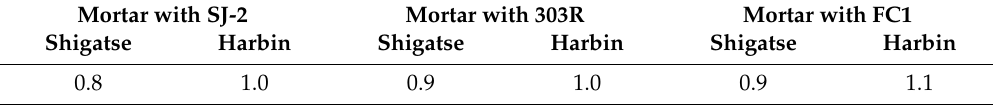
Table 6. Air content loss 1 of mortar prepared in di ff erent atmospheric pressures, %.